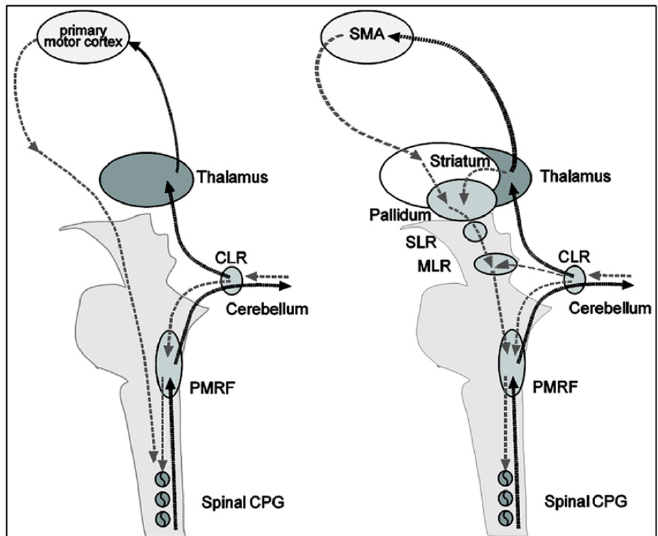
Figure 7. Illustration of the executive and planning networks of locomotion, as suggested in [105]. Execution of locomotion in a non-modulatory steady state ( left side ) goes from the primary motor cortex areas directly to the spinal central pattern generators (CPG), thereby bypassing the basal ganglia and the brainstem locomotor centers. A feedback loop runs from the spinal cord to the cerebellum and, thereby, via the thalamus to the cortex. For planning and modulation of locomotion ( right side ), cortical locomotor signals originate in the prefrontal supplementary motor areas and are transmitted through the basal ganglia via disinhibition of the subthalamic locomotor region (SLR) and mesencephalic locomotor region (MLR), where they converge with cerebellar signals from the cerebellar locomotor region (CLR). The MLR functionally represents a cross point for motor information form basal ganglia and cerebellar